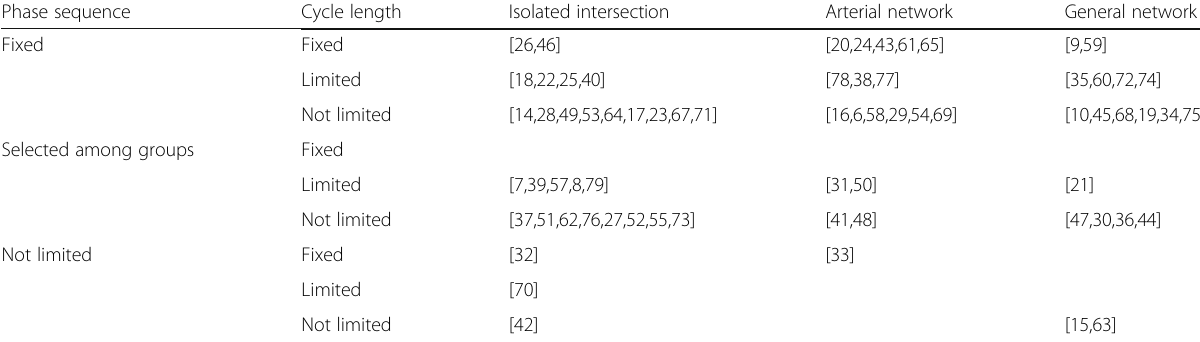
Table 5 Literature summary based on intersection networks and signal timing constraints